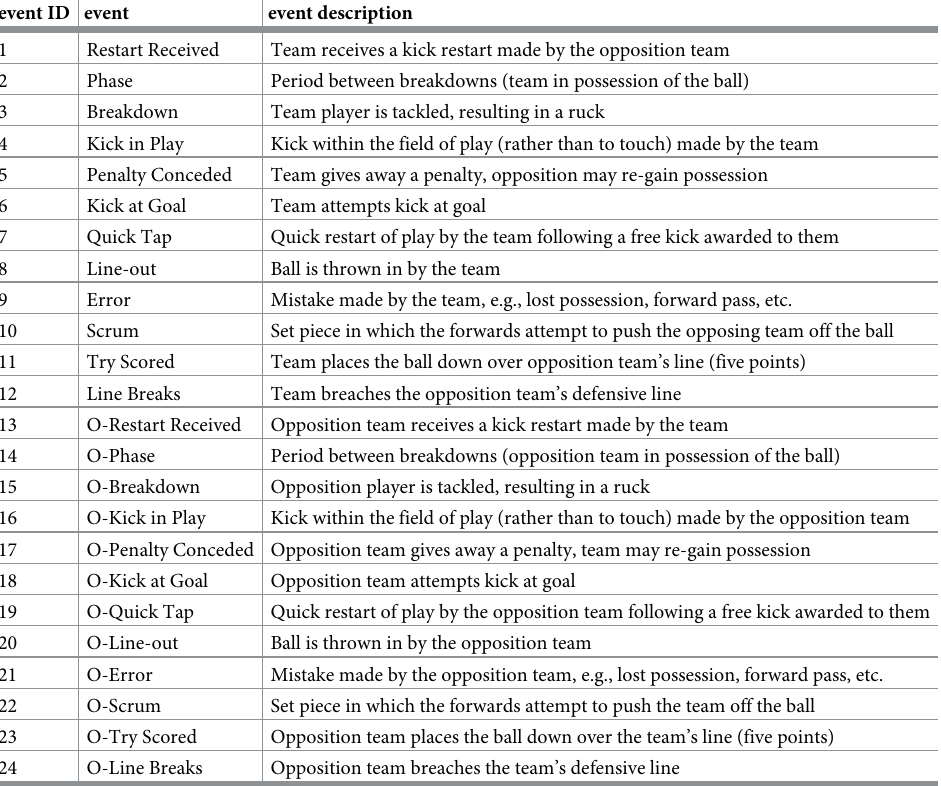
Table 2. Unique events in the original XML data. Events prefixed by “O-” are performed by the opposition team; those that are not are performed by the